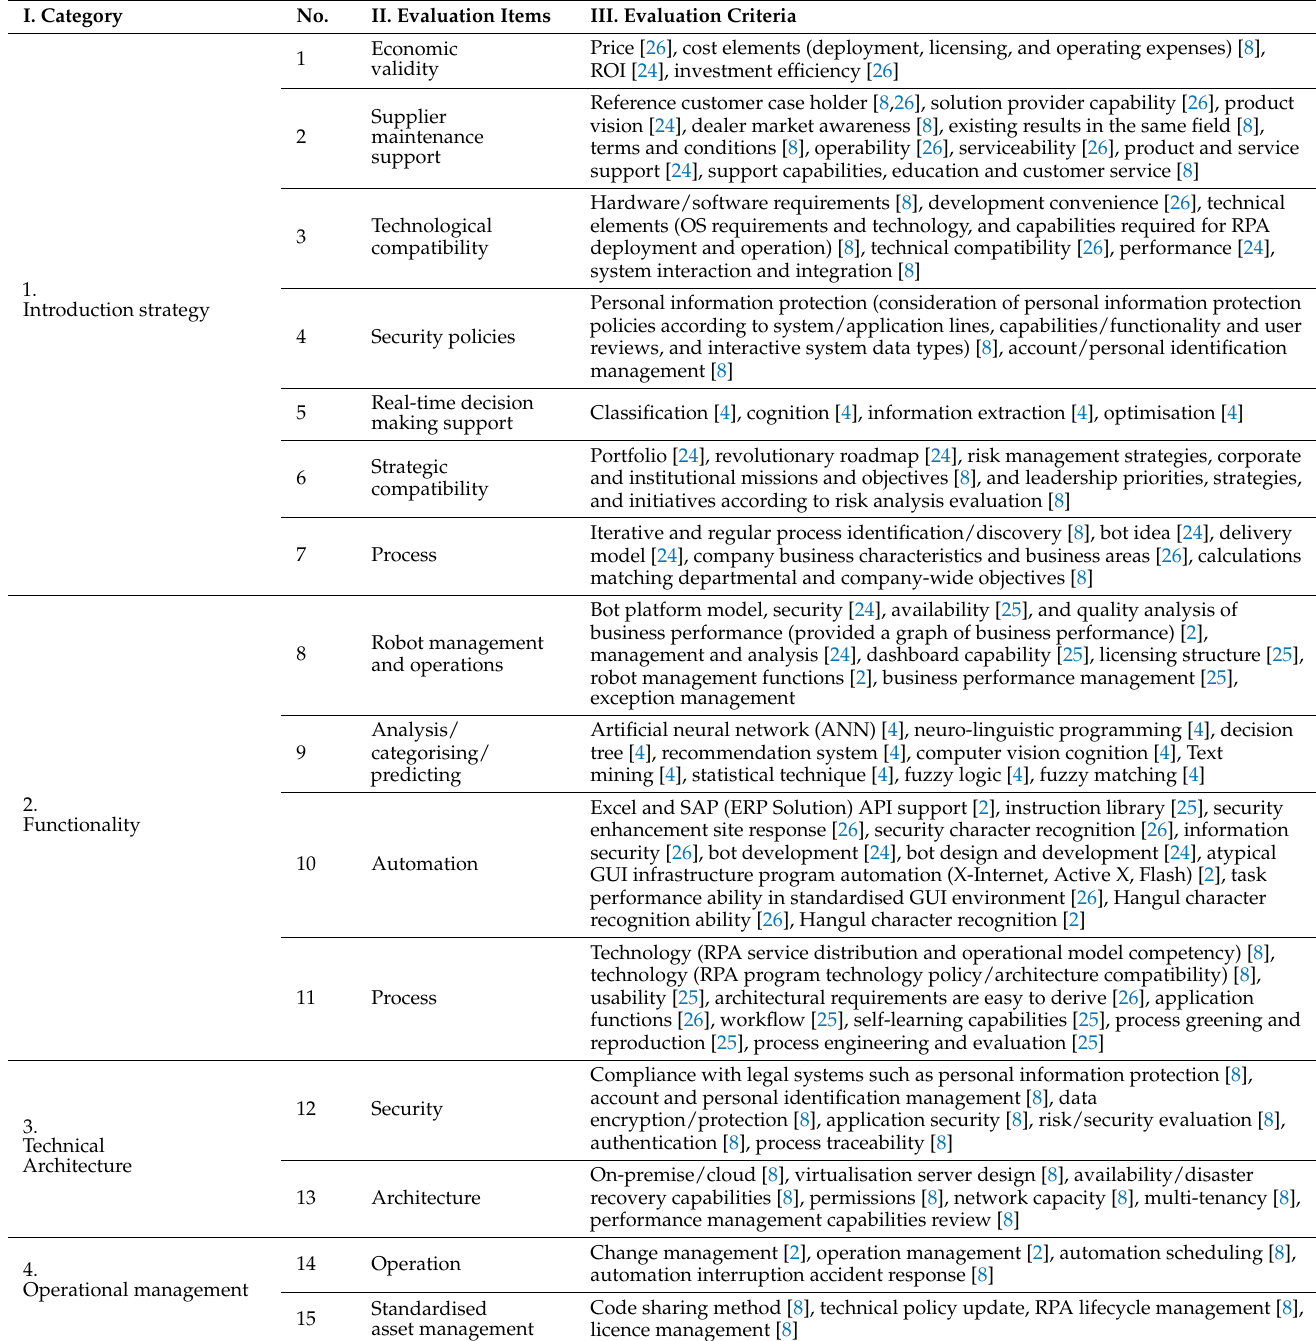
Table 4. Derived results for evaluation criteria for RPA solution